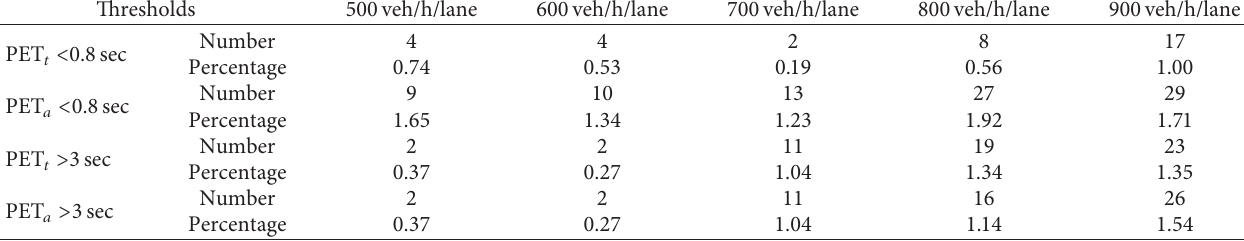
Table 2: Conflicts of which PET t and PET a are beyond two thresholds.